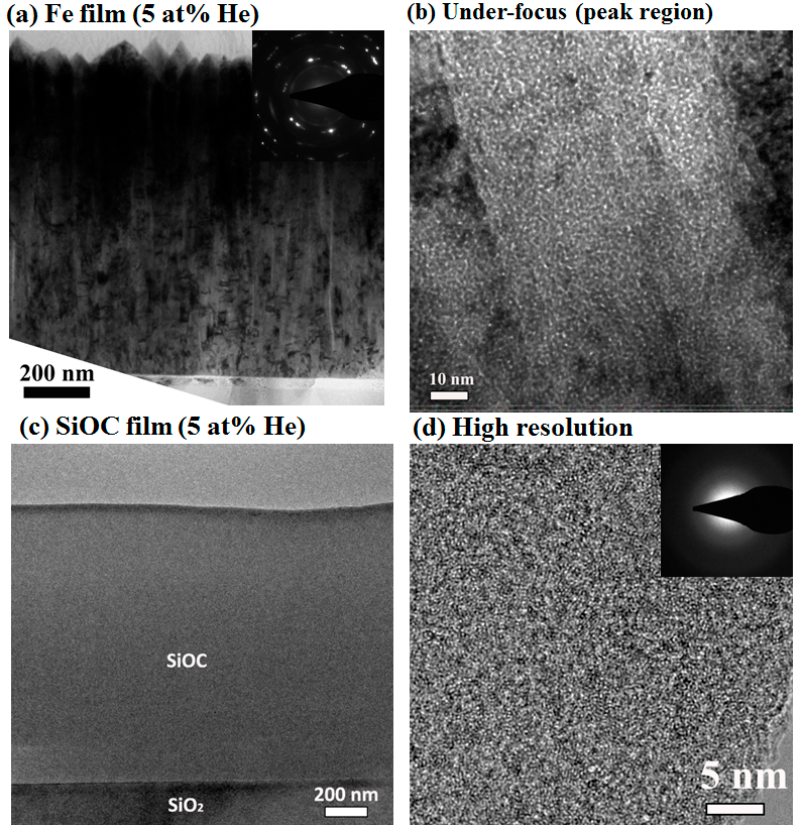
Figure 2. The typical cross-sectional TEM images of ( a ) pure Fe film and ( c ) pure SiOC film after 5 at% He implantation. The high-resolution TEM images of He peak regions are shown as ( b ) and ( d ), respectively.